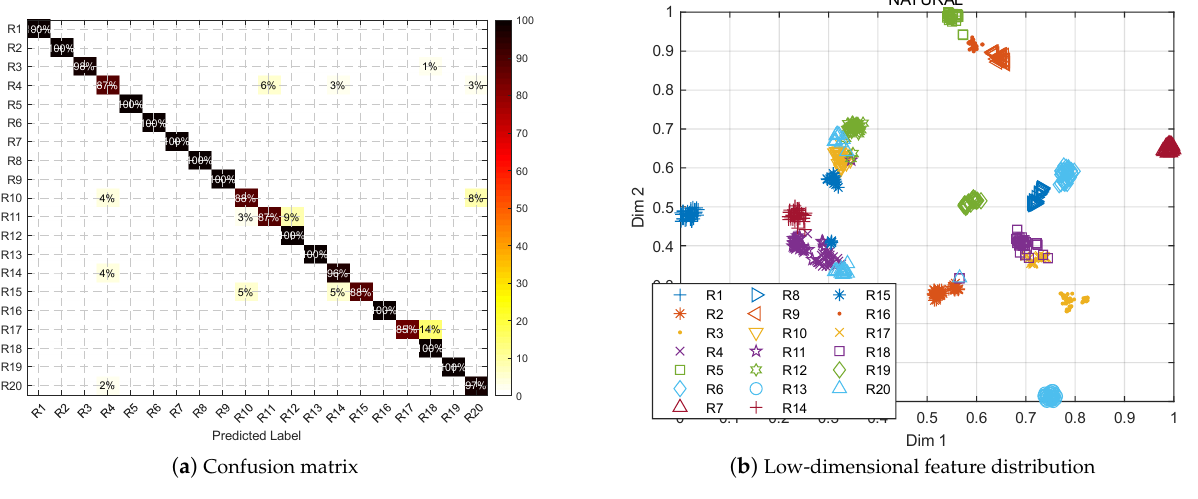
Figure 14. Identification performance and the feature distribution of the DNN after AT for Dataset 1. The average identification accuracy is P =